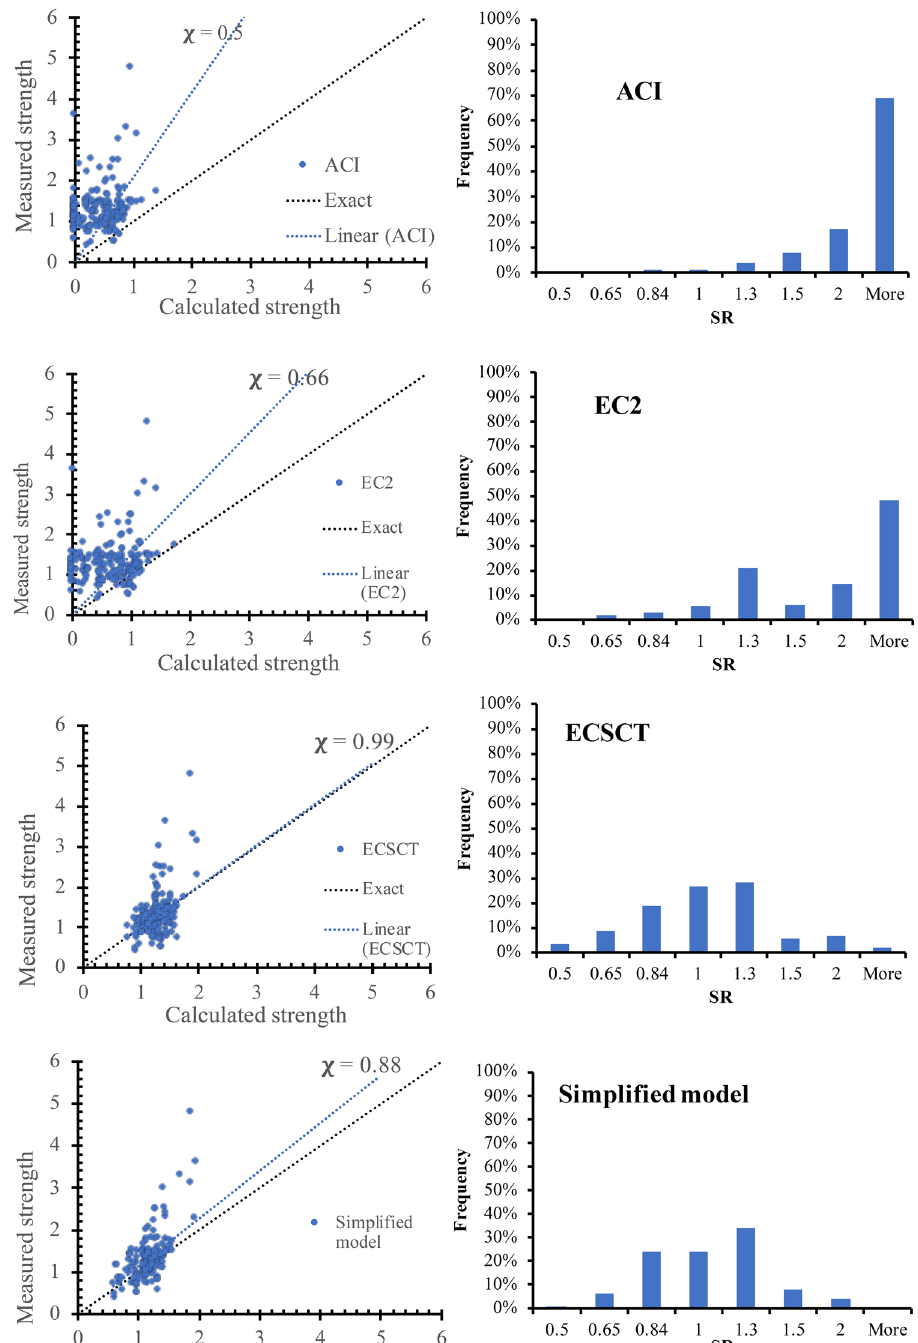
Figure 6. Measured Strength versus calculate strength using various